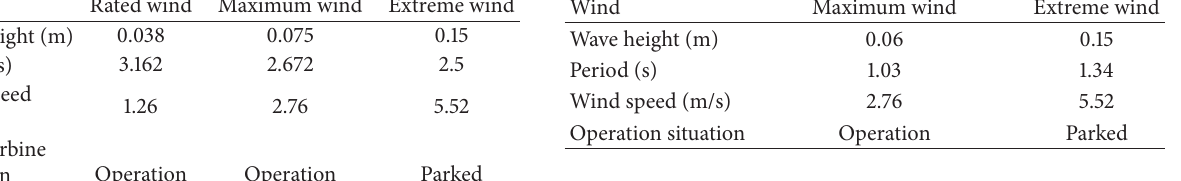
Table 5: Combination of a typical wind and an irregular wave.